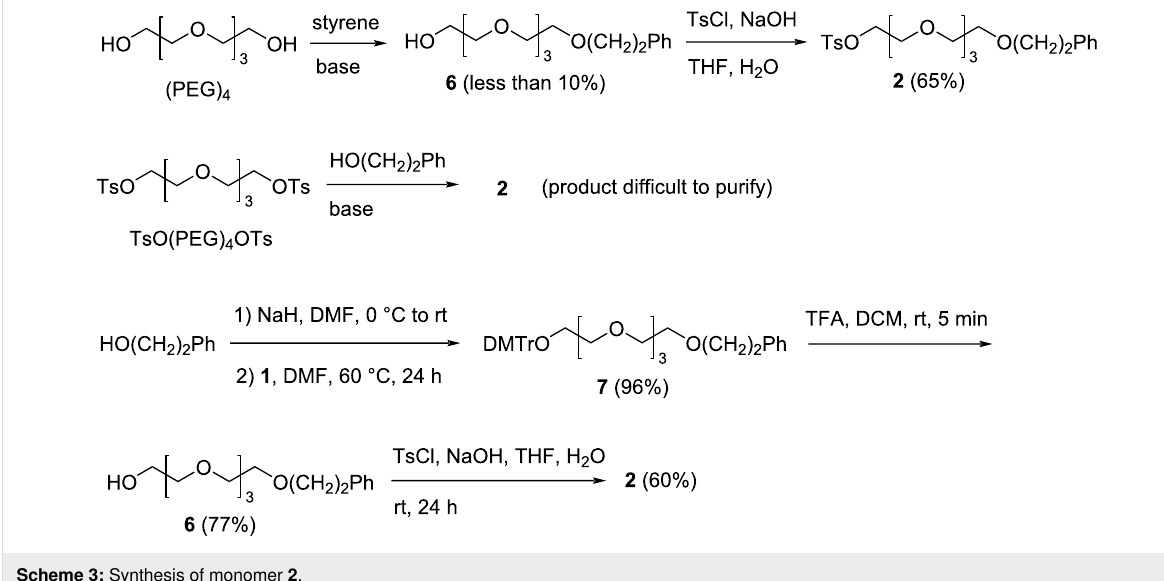
2 . This route is longer than the other two, but the products of